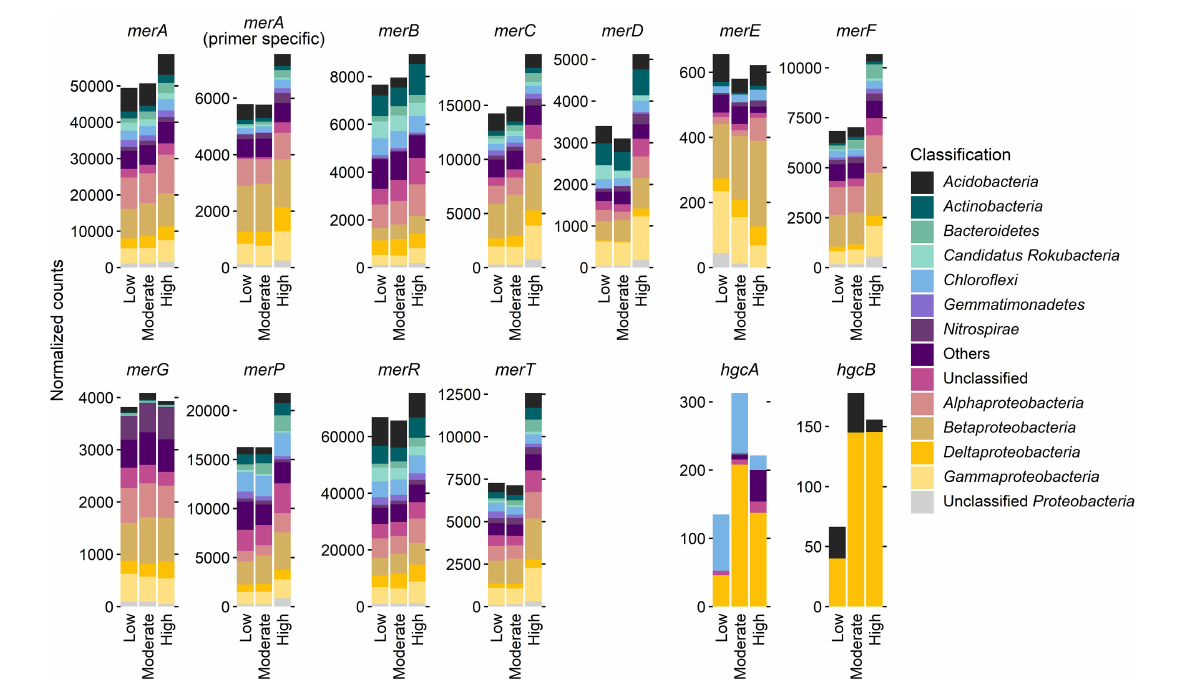
critical limit concentration for soluble Hg of 0.004 µ g Hg kg − 1 soil (4 mg Hg kg − 1 ), which is considerable higher than the water-extractable Hg concentration of 70 µ g Hg kg − 1 )